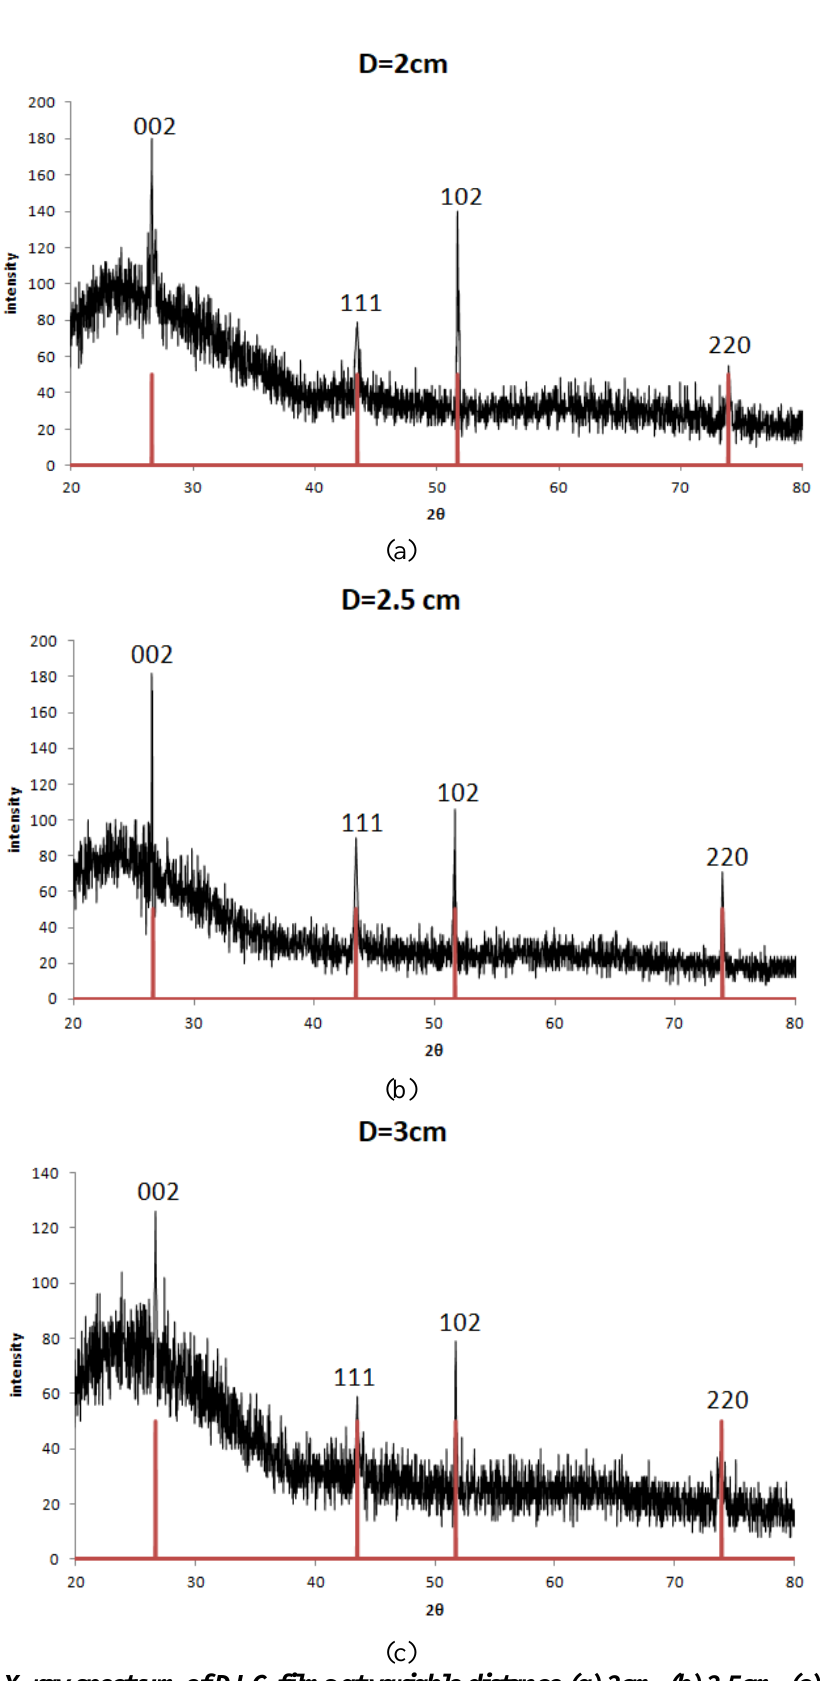
Fig.5: X-ray spectrum of DLC films at variable distance (a) 2cm, (b) 2.5cm,